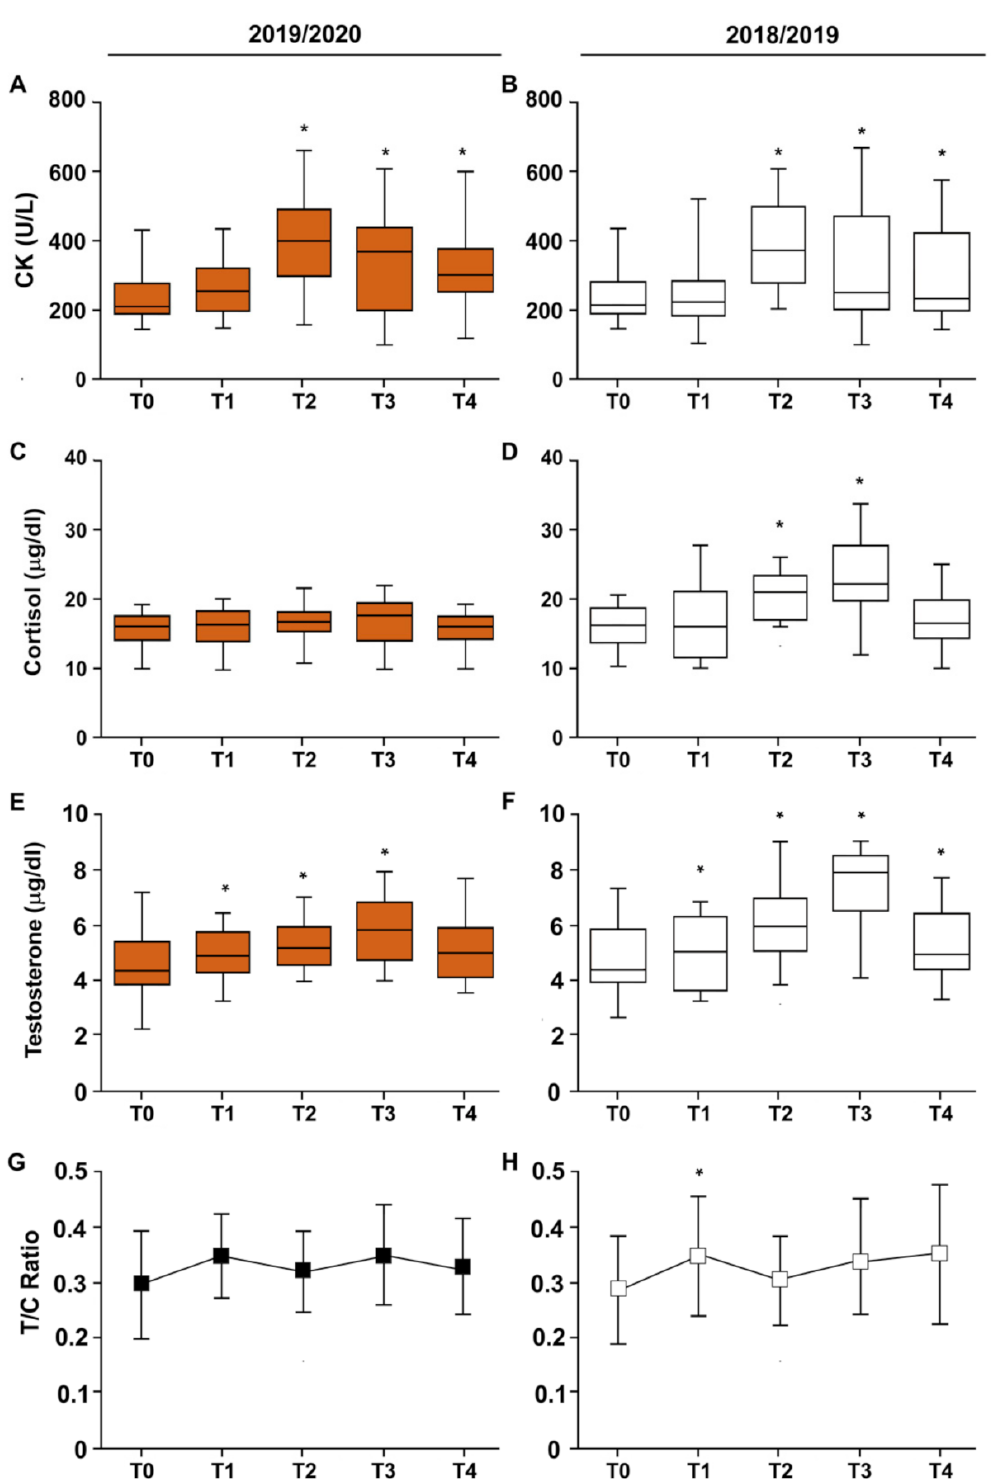
Figure 4. The effects of training on serum CK ( A , B ), cortisol ( C , D ), testosterone concentration ( E , F ), and T/C ratio ( G , H ), in football players during the 2018/2019 and 2019/2020 seasons. Box and whiskers representation of serum CK, cortisol, and testosterone concentration and T/C ratio evaluated five times (T0, T1, T2, T3, and T4) during the seasons. In this representation, the central box covers the middle 50% of the data values, between the upper and lower quartiles. The bars extend out to the extremes, while the central line is at the median. p -values were obtained by Student’s paired t -test between each timepoint and T0. * p <